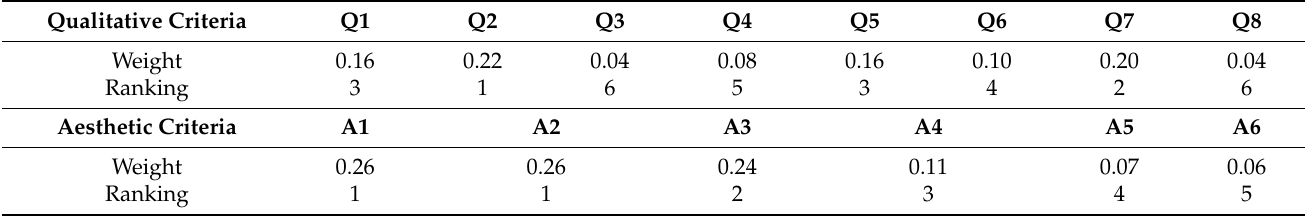
Table 12. Ranking of qualitative and aesthetic criteria. Own